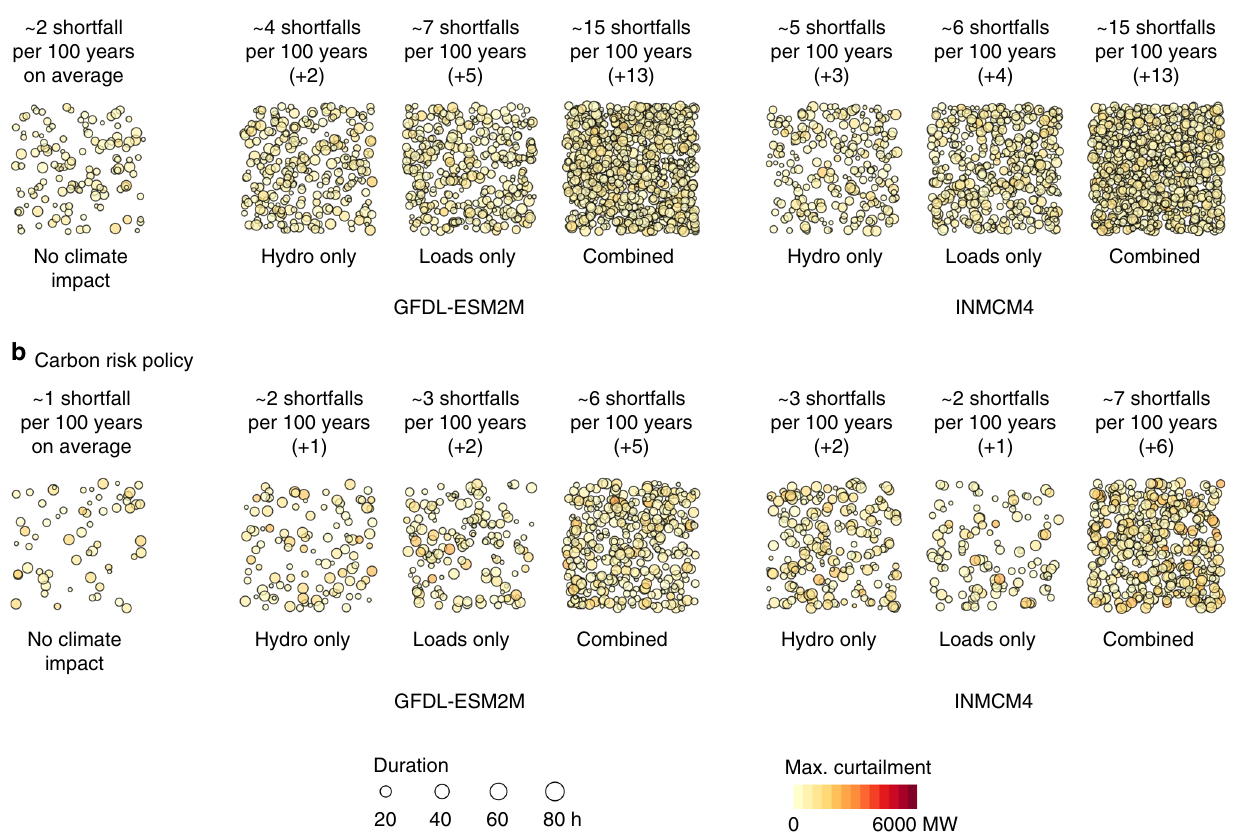
Fig. 4 Power shortfall events with isolated and combined impacts. Results are given for summer 2035 for existing policy and carbon risk policy cases. Each point represents a simulated shortfall event out of 6000 simulations. Number of points indicates frequency of occurrence, whilst size and color give duration and maximum curtailment, respectively. Points are positioned randomly inside each